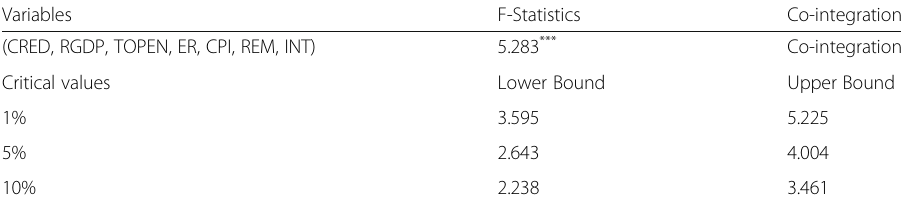
Table 3 Credit to the private sector as a share GDP is the dependent variable Variables